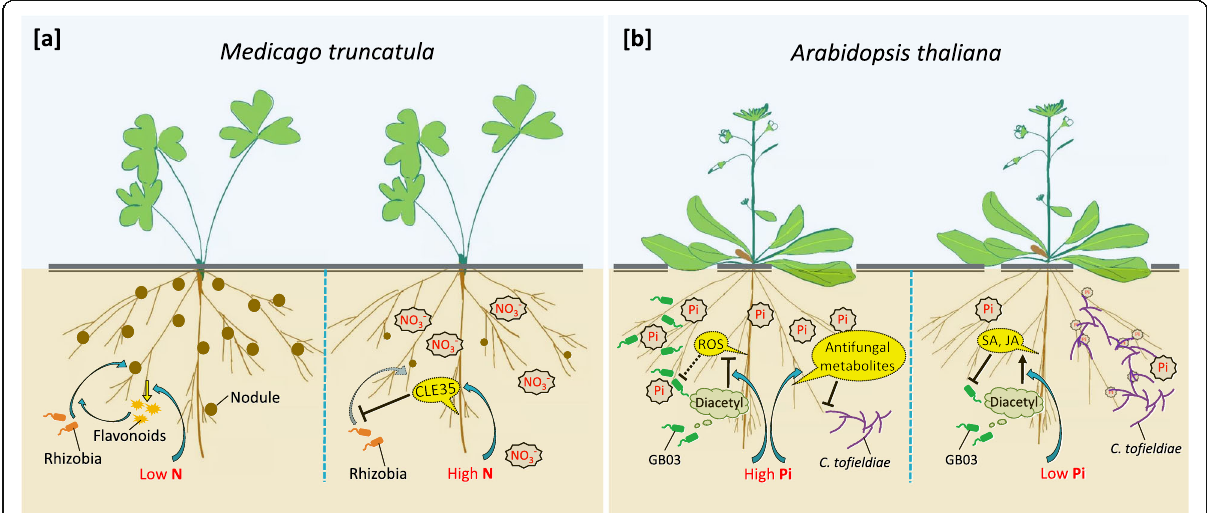
Fig. 2 Nutrition-dependent plant-microbe association highlights plant ’ s initiative in determining the relationships. a Low N availability increases root production of flavonoids, which induce rhizobial production of nodulation factors that in turn provoke nodule formation for N 2 fixation. By contrast, high N availability transcriptionally induces CLE35, which suppresses rhizobia infection and consequently nodulation (Moreau et al. 2021). b Under P sufficient conditions, Arabidopsis plants respond to the GB03-released volatile compound diacetyl with decreases in the microbe-induced ROS burst, thereby providing a permissive environment for the bacterial association; whereas under P deficient conditions, the plants respond to diacetyl with strong activation of salicylic acid (SA)- and jasmonic acid (JA)-mediated defense, thereby deterring the bacterial association (Morcillo et al. 2020). By contrast, Arabidopsis deploy a different strategy for determining the relation with C. tofieldiae , an endophytic fungus that can transfer phosphate to its host. The plants allow the symbiosis with C. tofieldiae only under P deficient conditions; whereas under P sufficient conditions, the plants deploy Trp- derived antifungal metabolites to deter the endophytic colonization of C. tofieldiae (Hiruma et al.